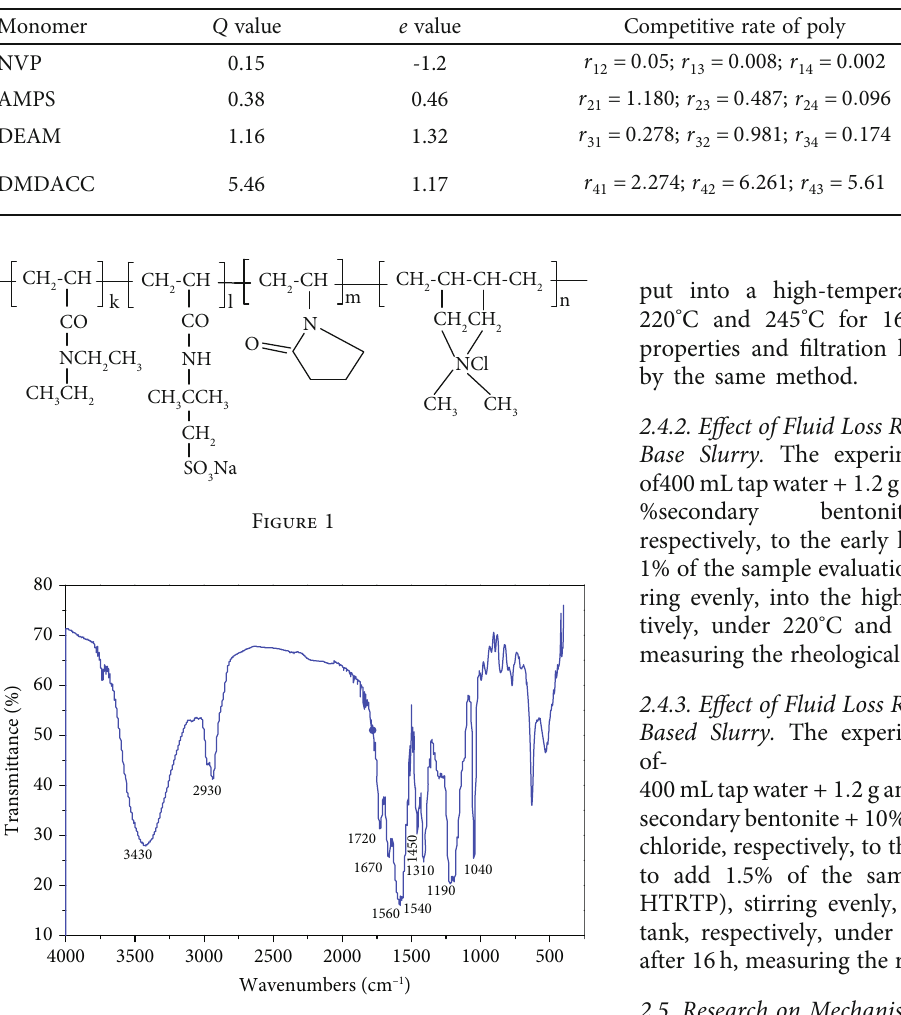
Figure 2: Infrared spectrogram of